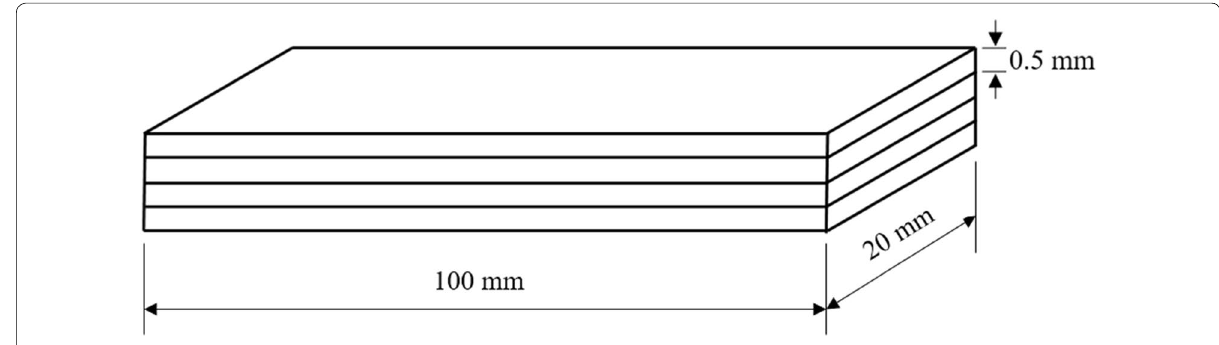
Fig. 1 A laminate is composed of four laminas